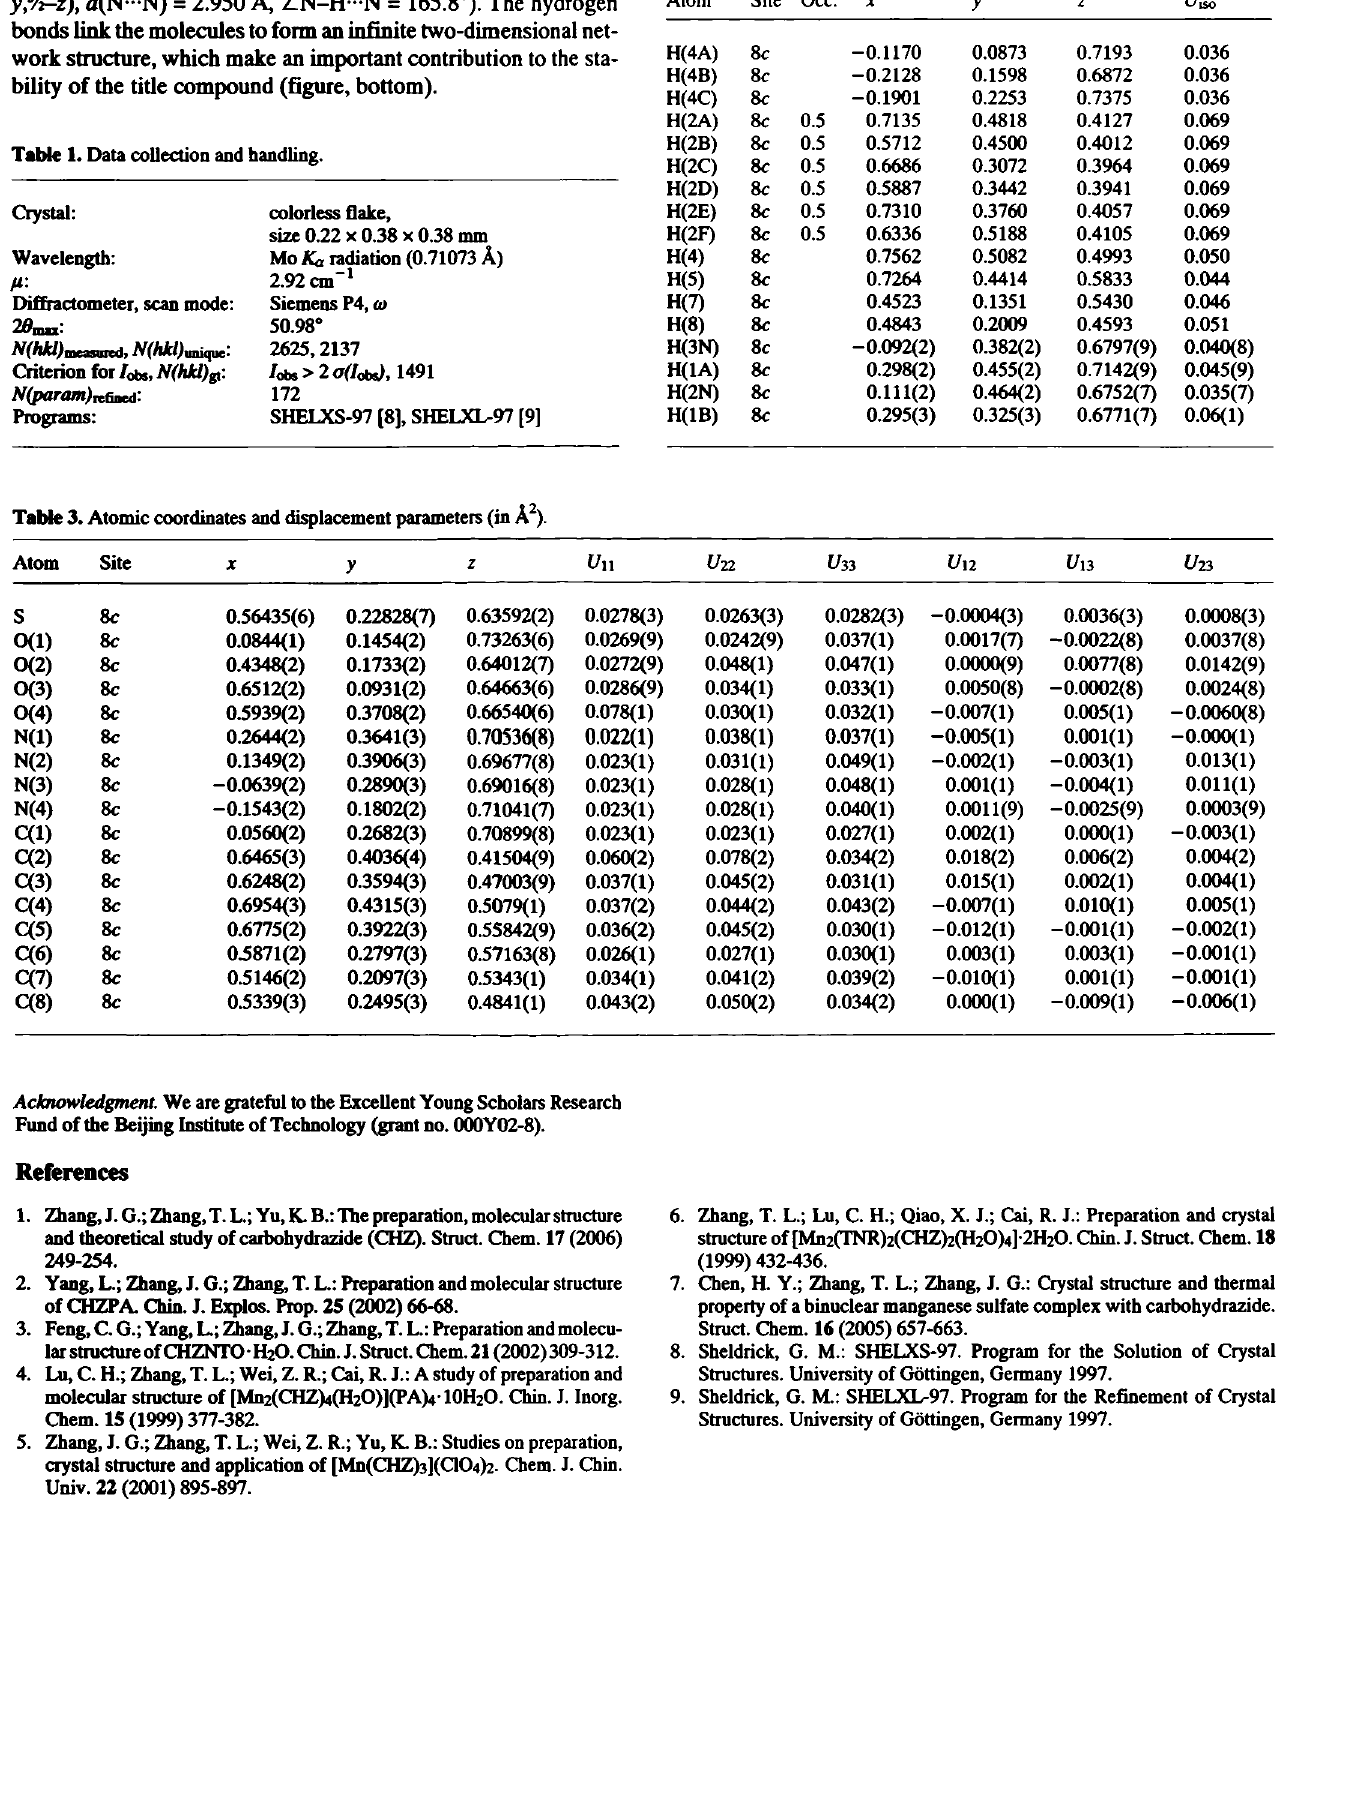
Table 3. Atomic coordinates and displacement parameters (in A 2